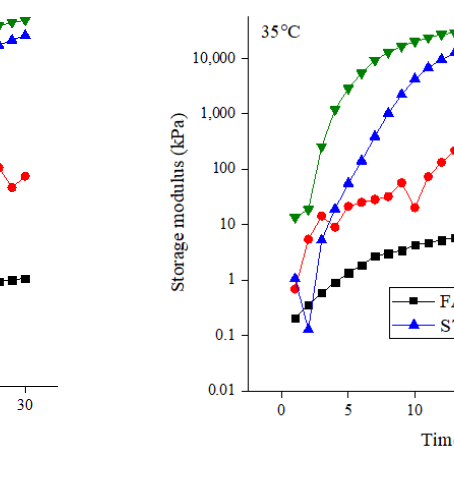
Figure 3. Evolution of storage modulus with the shear strain: NaOH molarity of ( a ) 4 M, ( b ) 6 M, ( c ) 8 M, and ( d ) 10 M. Table 3. LVER limit, LVER proposal and storage modulus of alkali-activated